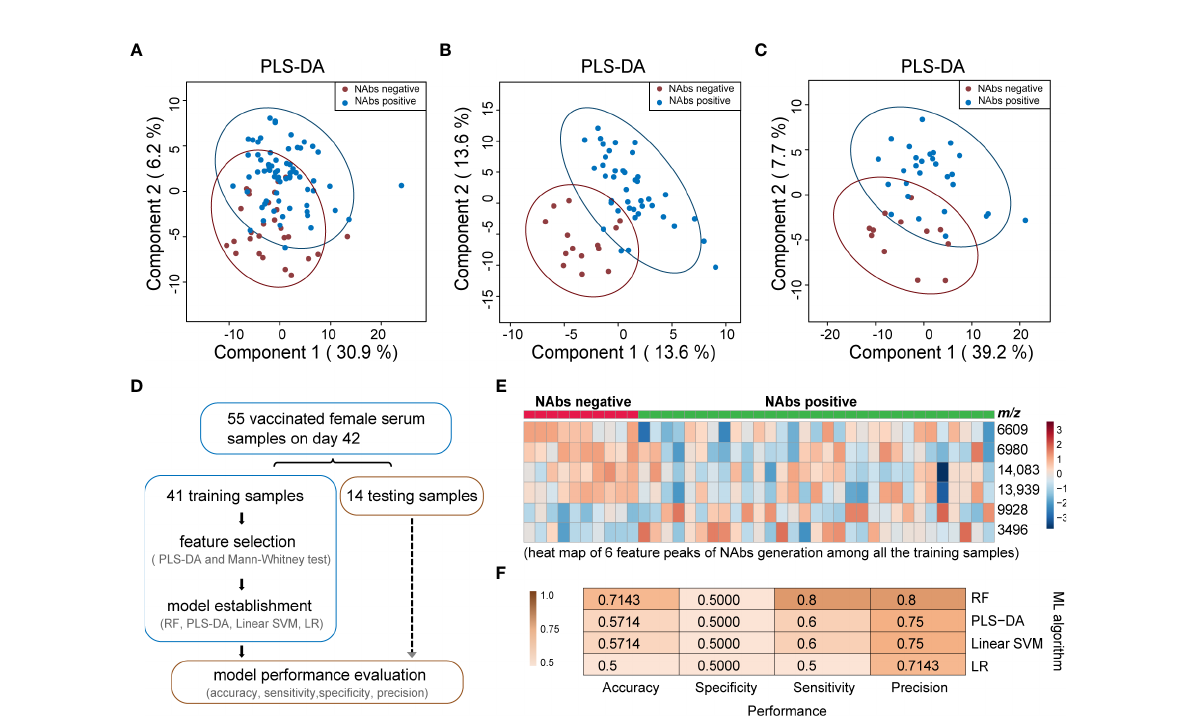
FIGURE 5 Classi fi cation of NAbs positive and negative based on MALDI-TOF MS serum peptidome. (A) PLS-DA analysis of all the 95 samples collected on day 42 to classify NAbs positive and negative; (B) PLS-DA analysis of 55 samples collected on day 42 from female individuals to classify NAbs positive and negative; (C) PLS-DA analysis of 40 samples collected on day 42 from male individuals to classify NAbs positive and negative; (D) a general scheme for feature selection and model establishment to classify NAbs positive and negative; (E) heat map of six feature peaks of NAbs generation among all the training samples; (F) performance of four classi fi cation models on the 14 test samples for NAbs generation prediction. N: negative, P: positive, RF: random forest, PLS-DA: partial least squares discriminant analysis, SVM: linear support vector machine, LR: logistic regression. The colored ovals represent 95% con fi dence